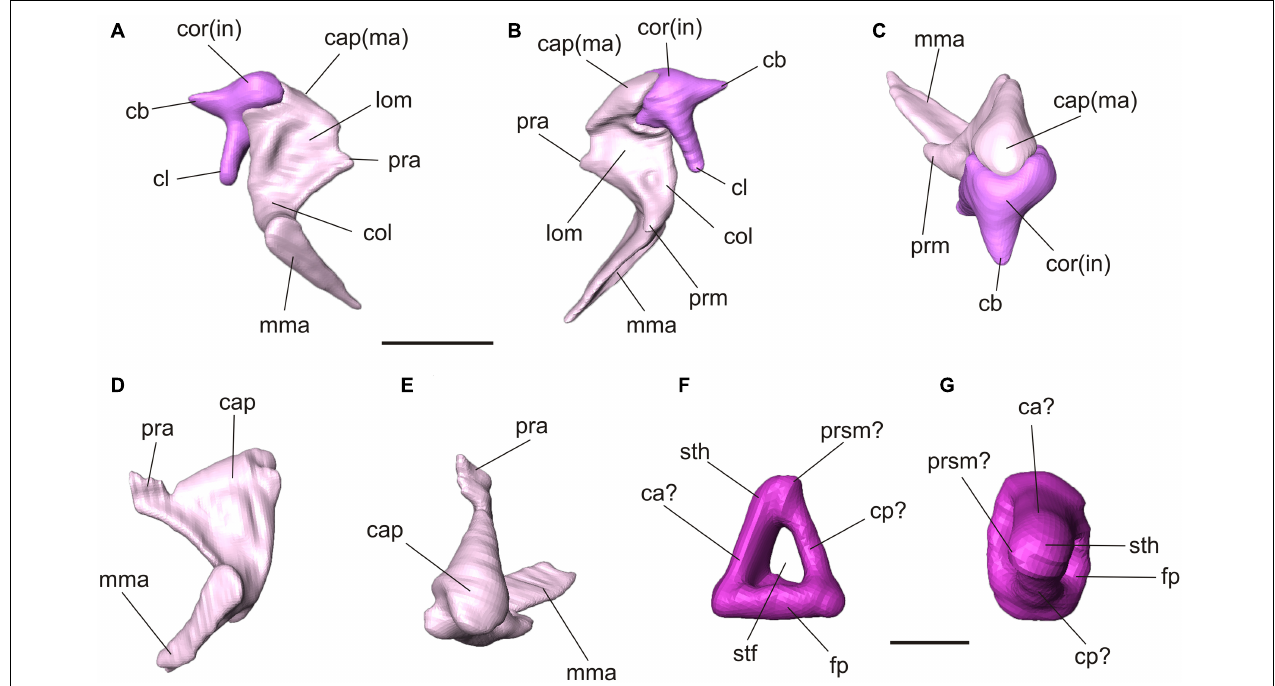
FIGURE 4 | Virtual 3D reconstructions of the auditory ossicles of Palaeolagus haydeni (FMNH PM9476). Color code refers to Figure 3 . Articulated right malleus and incus in lateral (A) , medial (B) and dorsal (C) views. Note the incomplete processus anterior of the malleus. Left malleus in lateral (D) and dorsal (E) views. Ventral (F) and medial (G) views of the left stapes. Interpretation of orientation is tentative due to displacement and weaker preservation of the right stapes. Abbreviations: ca, crus anterior; cap, caput; cb, crus breve; cl, crus longum; cp, crus posterior; col, collum; cor, corpus; fp, footplate; in, incus; lom, lamina ossea mallei; ma, malleus; mma, manubrium mallei; pra, processus anterior; prm, processus muscularis; prsm, process for stapedial muscle; stf, stapedial foramen; sth, stapedial head. Scale bar for (A–E) = 2 mm, (F–G) =